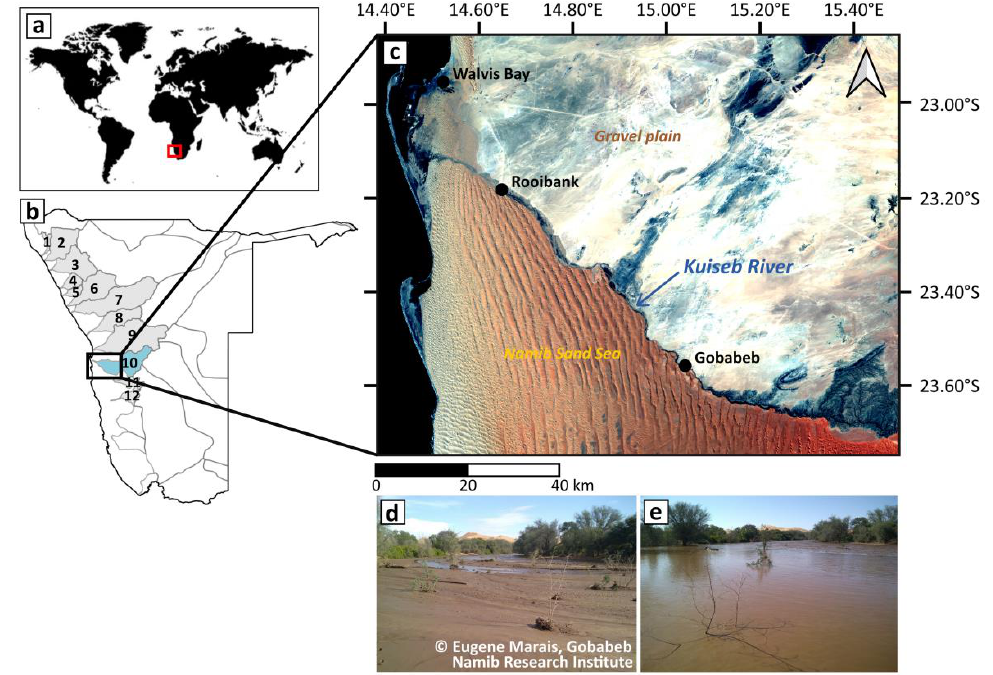
Figure 1. ( a ) World map and location of Namibia with a red box. ( b ) Locations of the 12 ephemeral rivers in Namibia, with the Kuiseb River highlighted in blue (number 10, from https://namibia.africageoportal.com/ (accessed on 4 April 2022)). ( c ) Sentinel-2 image of the Kuiseb River, ( d ) picture taken by the Gobabeb Research Center at the arrival of the flood mid-January 2021, and ( e ) the flood in the Kuiseb River after 4 days.